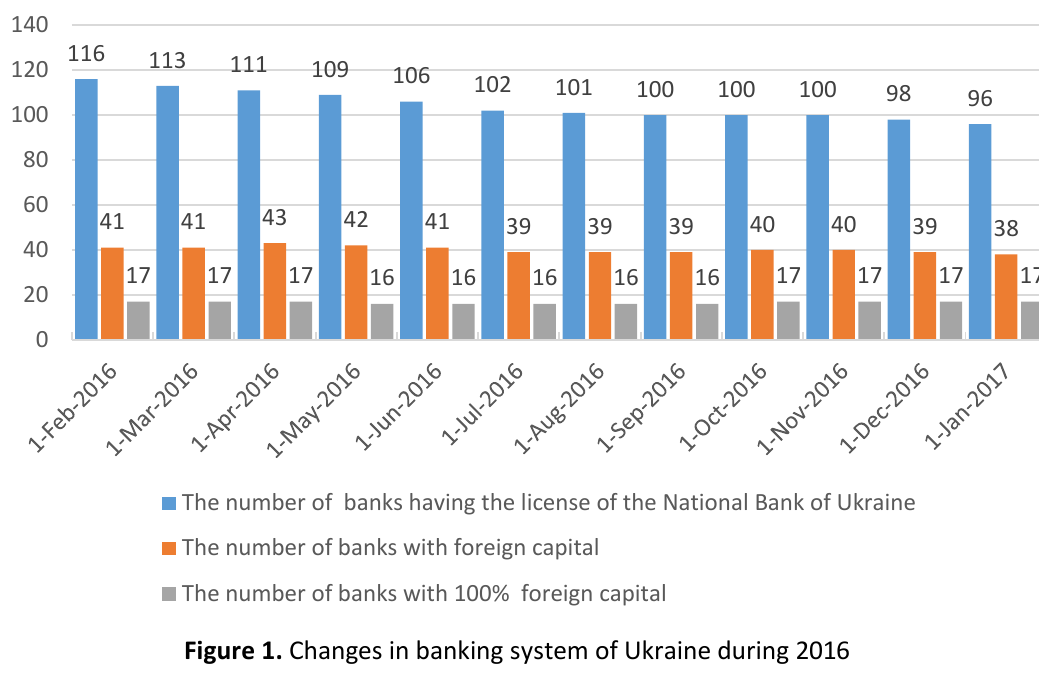
Figure 1. Changes in banking system of Ukraine during